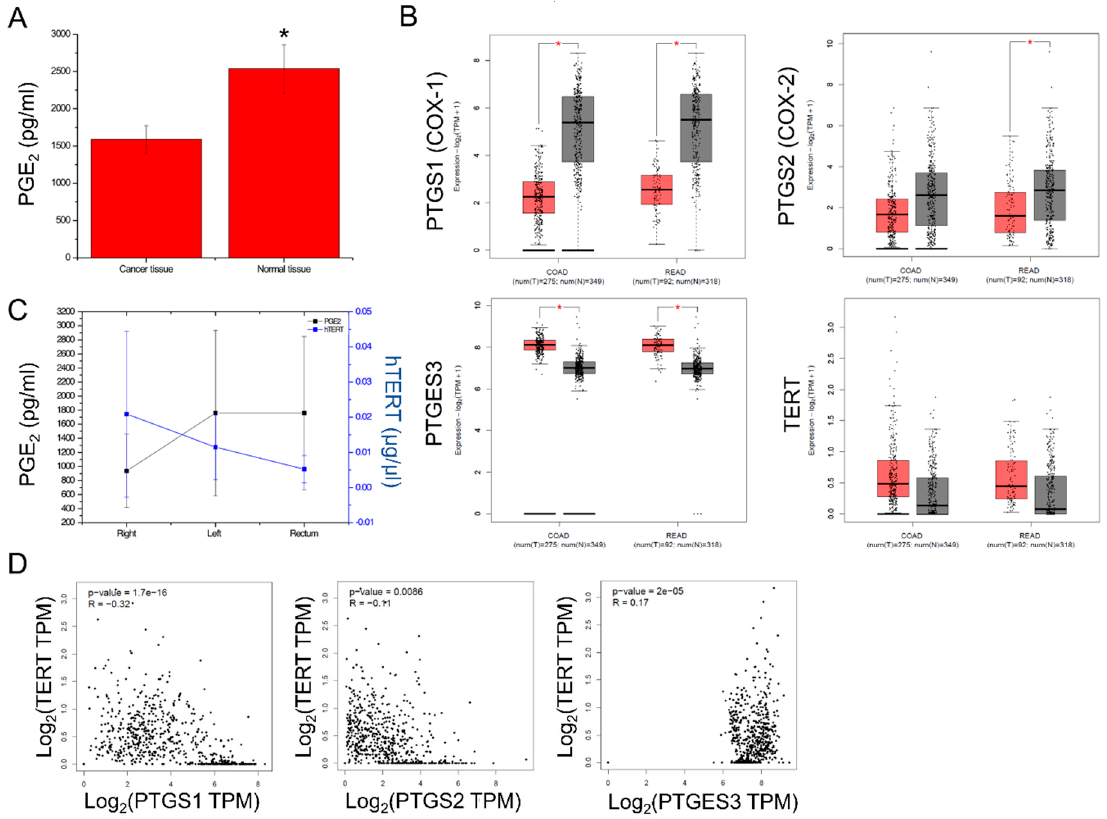
Figure 2. PGE 2 levels were significantly lower in colorectal cancer (n = 49), compared to the adjacent normal tissue samples (* p < 0.01) ( A ). PTGS1 (COX-1) and PTGS2 (COX-2) mRNA levels were significantly lower across COAD and READ tumors compared to the normal mucosa (TCGA and GTEx). On the other hand, PTGES3 (COX-3) and TERT mRNA levels were significantly upregulated in the tumors ( B ). TERT activity decreased from right to left colon, and rectum cancers; conversely, PGE 2 levels increased respectively ( p = 0.006) ( C ). TERT expression was inversely correlated with the expression of PTGS1 and PTGS2, but not with the expression of PTGES3 in the TCGA-COAD dataset ( D ).